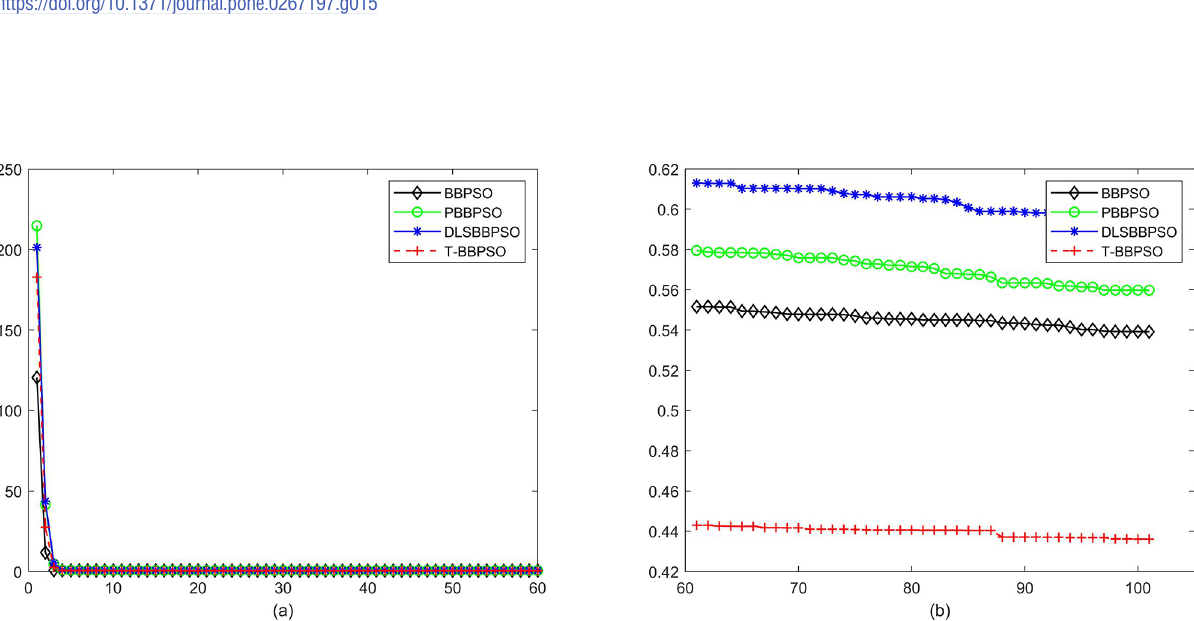
Fig 15. Comparison of convergence speed between BBPSO, PBBPSO, DLS-BBPSO and TBBPSO, f 13 , (a) iteration 0–6000, (b) iteration 6000–10000 the unit is 100 iteration.